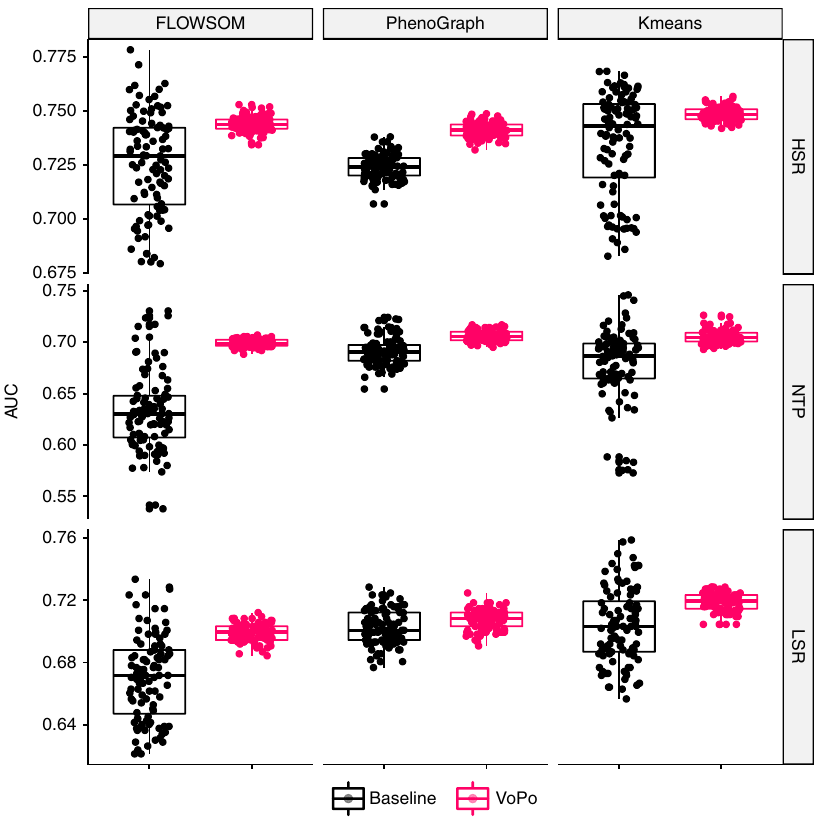
Fig. 3 Applying the VoPo framework across clustering algorithms. Implementing repeated metaclustering within the VoPo framework improved accuracy and increased robustness across datasets and clustering algorithms. Regardless of whether PhenoGraph, FlowSOM, or k -means was used in the clustering and metaclustering components of VoPo, repeated metaclustering with VoPo (pink boxplots) lead to higher average classi fi cation accuracy (AUC) with less variability over the baseline case where VoPo was not applied (black boxplots). The boxplots show median values, interquartile range, whiskers of 1.5 times interquartile range, and all individual